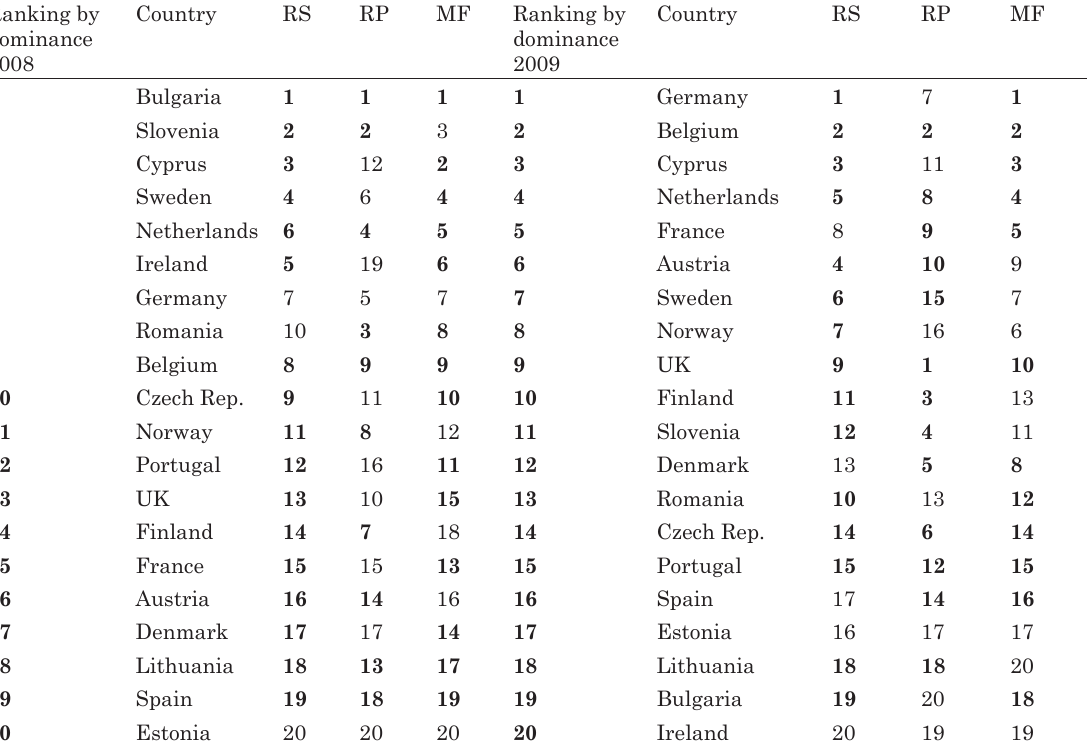
Table 2. ranking by dominance of the construction sector in 20 european countries by mUlTImoora (a) ranking by